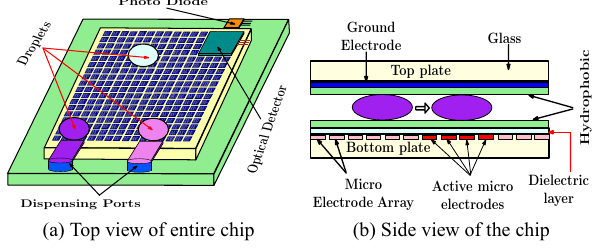
Fig. 3 Architecture of MEDA-based